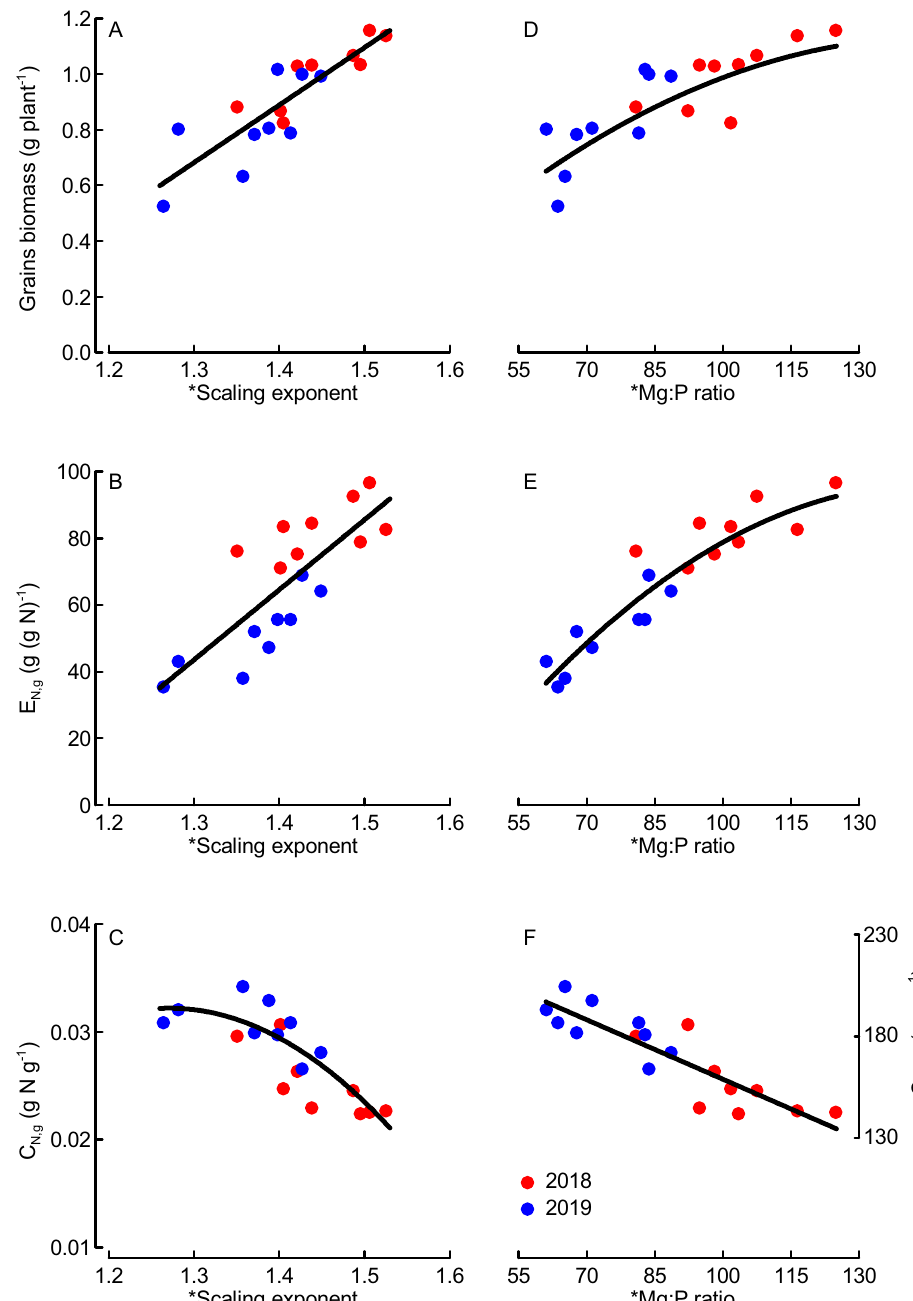
Figure 5. Grains biomass, grain-specific nitrogen (N) efficiency (E N,g ) and grain N concentration (C N,g ) or grain protein concentration (C prot,g ) as functions of the scaling exponent for macroelements ( A to C ) and Mg:P ratio ( D to F ) for nine wheat varieties field-grown in Sweden during two years (2018, 2019). *Indicates that scaling exponents were based on data from tillering (BBCH29) and flowering (BBCH65) 35 . Regressions: y = 2.069x − 2.008, N = 18, R 2 = 0.73, P < 0.001 ( A ); y = 209.9x − 229.34, N = 18, R 2 = 0.63, P < 0.001 ( B